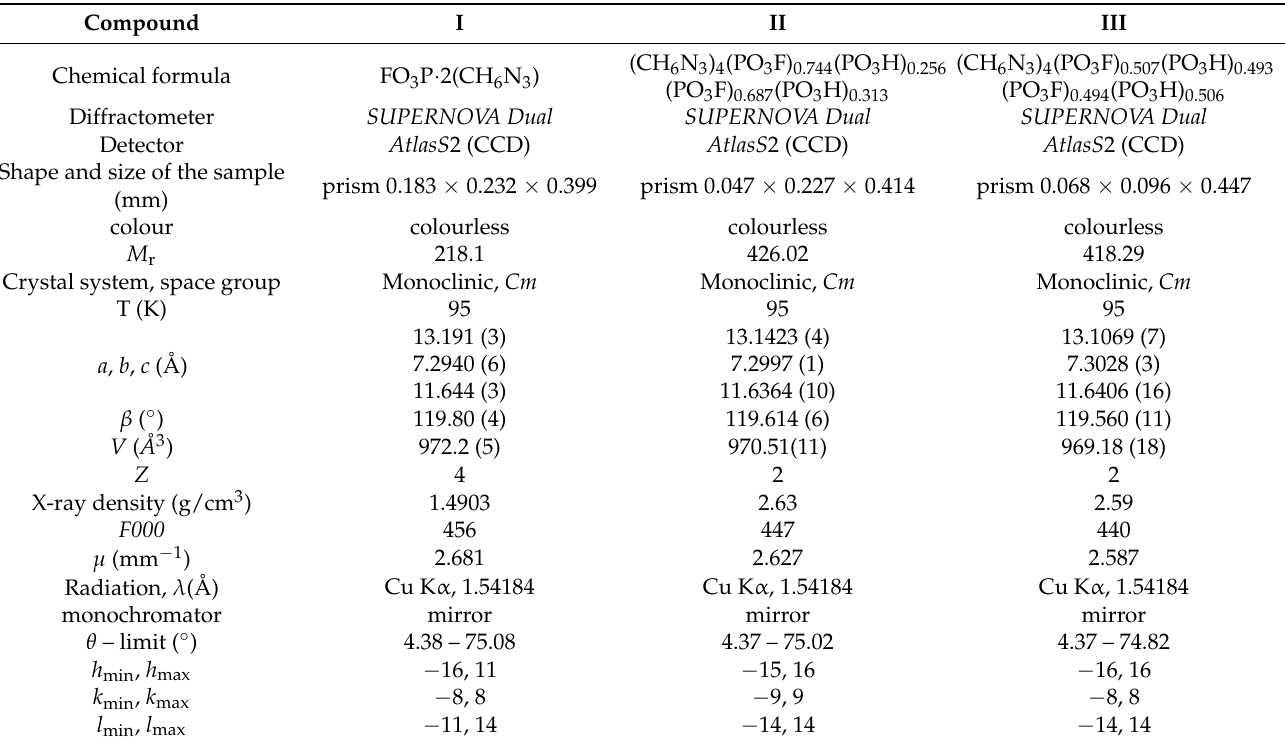
Table 1. Crystal data and details of data collection and refinement for compounds ( I ), ( II ) and ( III